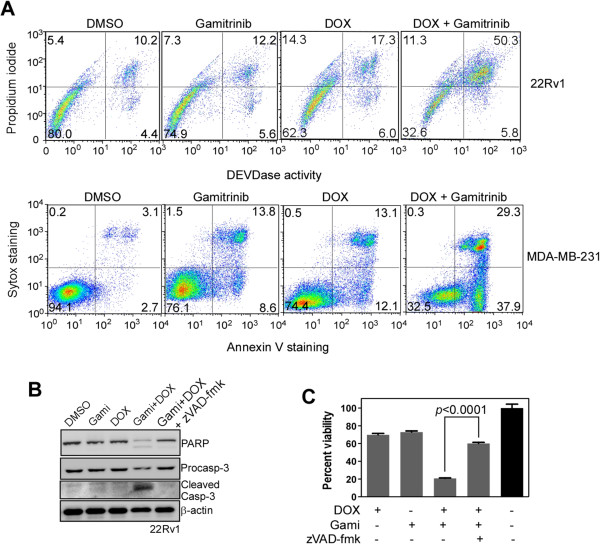
Induction of apoptosis by combination treatment. (A) Cell death analysis. 22Rv1 and MDA-MB-231 cells were treated with 0.25 μM DOX/2.5 μM gamitrinib and 10 μM DOX/5 μM gamitrinib, respectively, as single agents or combination treatment for 24 hours, and analyzed for propidium iodide, Sytox, Annexin V staining, and DEVDase activity by flow cytometry. The percentage of cells in each quadrant is indicated. (B) Caspase activation by the drug combination. 22Rv1 cells were treated with 0.25 μM DOX and 2.5 μM gamitrinib, and analyzed by western blotting. The pan-caspase inhibitor zVAD-fmk was used at a concentration of 10 μM. (C) Effect of caspase inhibitor on the drug combination treatment. 22Rv1 cells were treated with 0.25 μM DOX, 2.5 μM gamitrinib, and 10 μM zVAD-fmk as indicated and analyzed by MTT assay. Percent viability compared with DMSO-treated control is shown. Data are the mean ± SEM of duplicated three independent experiments.